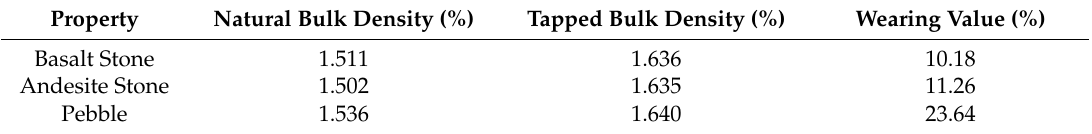
Table 4. Properties of coarse